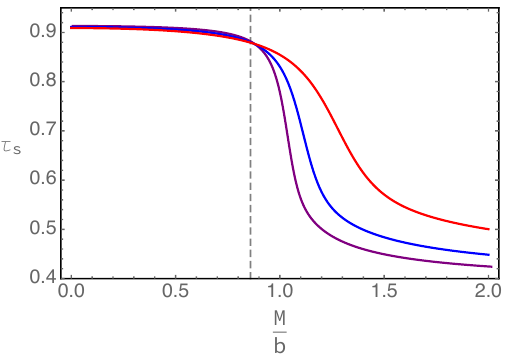
Figure 7 . Plots of the proper time τ s from the horizon to the singularity as a function of M/b at different temperatures T/b = 0 . 05 (red), 0 . 02 (blue), 0 . 01